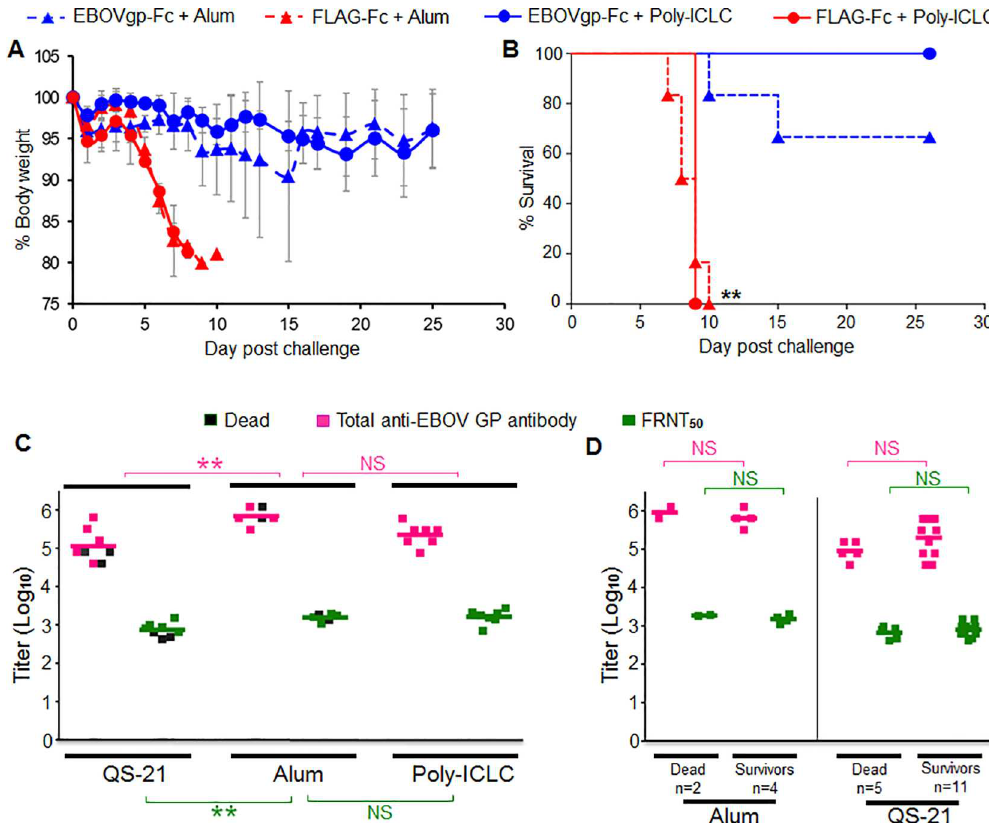
Fig 5. EBOV lethalchallengeof guineapigsimmunizedwithEBOVgp-Fc vaccine usingdifferent adjuvants. Groupsof guineapigs vaccinated with alum (triangles)or poly-ICLC(circles)adjuvanted EBOVgp-Fc (n = 6 alum or n = 7 poly-ICLC, blue) or FLAG-Fc (n = 7, red) vaccines were challengedwith 1,000 pfu of EBOV/May-GPA three weeks afterthe thirdboost. (A) Weight loss afterchallengewith EBOV. Guineapigs were weighed for 25 days. Data are group averages and bars indicatethe standarderrorof the mean.(B) Kaplan-Meiersurvivalcurves are plottedas percentsurvivalfor each vaccination group. Highly significant differences ( ** , P < 0.01)between vaccinated (EBOVgp-Fc) and control(FLAG-Fc) animalsas determined by the Mantel-Coxtest. (C) Comparison of anti-GPhumoralresponsesin guineapigs vaccinated with EBOVgp-Fc using differentadjuvants. The Hartley guineapigs were used in the QS-21experiments whereasstrain 13 guineapigs were used in the alum and poly- ICLC experiments. Titersof total anti-GPantibody(magenta)and neutralizingantibodies(FRNT 50 , green)elicited by the EBOVgp-Fc vaccine using QS-21(datafromFigs 2 and 3), alum(datafromFigs 4 and 5B), or poly-ICLC (datafromFigs 4 and 5B) are shown as squaresfor each vaccinated animalin a group. Guineapigs that did not survivethe lethal challengeare markedwith gray squares. ANOVA and Bonferronitest were used to compare antibodylevels between two adjuvant groups. Highly significant( ** , p < 0.01) and non-significant (NS) differences between two adjuvant groups are shown in the graph for anti-GPtotal(magenta)and neutralizing(green) antibodies.(D) Anti-GPtotaland neutralizingantibodytitersof guineapigs immunized with the EBOVgp-Fc (n = 6) vaccine adjuvanted with alum (leftpanel)or the EBOVgp-Fc (n = 8) or EBOVgp Δ muc-Fc (n = 8) vaccines adjuvanted with QS-21and challenged with EBOV/May-GPA. Animalswere grouped according to the outcomein animalsthat died (Dead)or survived(Survivors) the challenge.The animalsimmunizedwith the QS21-adjuvanted EBOVgp-Fc or EBOVgp Δ muc-Fc vaccines were combinedinto the Dead (n = 5) and Survivors(n = 11)